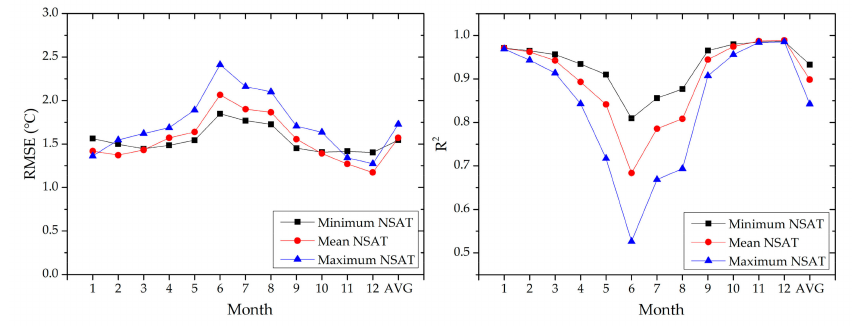
Figure 6. RMSE and R 2 of the predicted monthly minimum, mean, and maximum near surface air temperature using the Kriging model in China in 12 months of 2010.